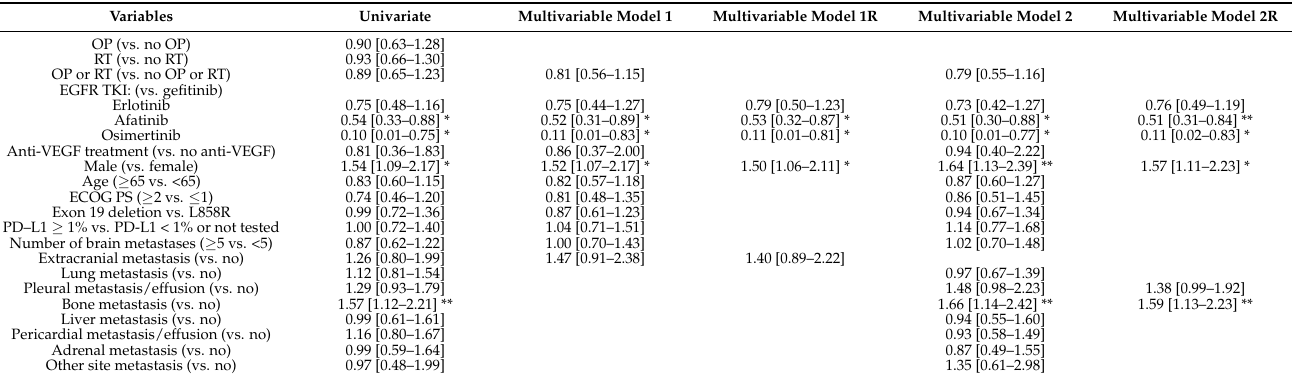
Abbreviations: ECOG, Eastern Cooperative Oncology Group; EGFR, epidermal growth factor receptor; OP, surgery for brain tumor; PD-L1, programmed death ligand 1; PS, performance status; RT, radiotherapy for brain tumor; TKI, tyrosine kinase inhibitor; VEGF, vascular endothelial growth factor. A patient with cancer harboring both the exon 19 deletion and L858R was included in the exon 19 deletion group. Data are presented as hazard ratio (HR) with 95% confidence interval. After building the maximal models of multivariable Cox regression (models 1 and 2), the corresponding reduced multivariable Cox regression models (models 1R and 2R, respectively) were built using backward variable selection, retaining only variables with p -values < 0.15. * p -value < 0.05; ** p -value < 0.01. Table 4. Factors associated with overall survival.